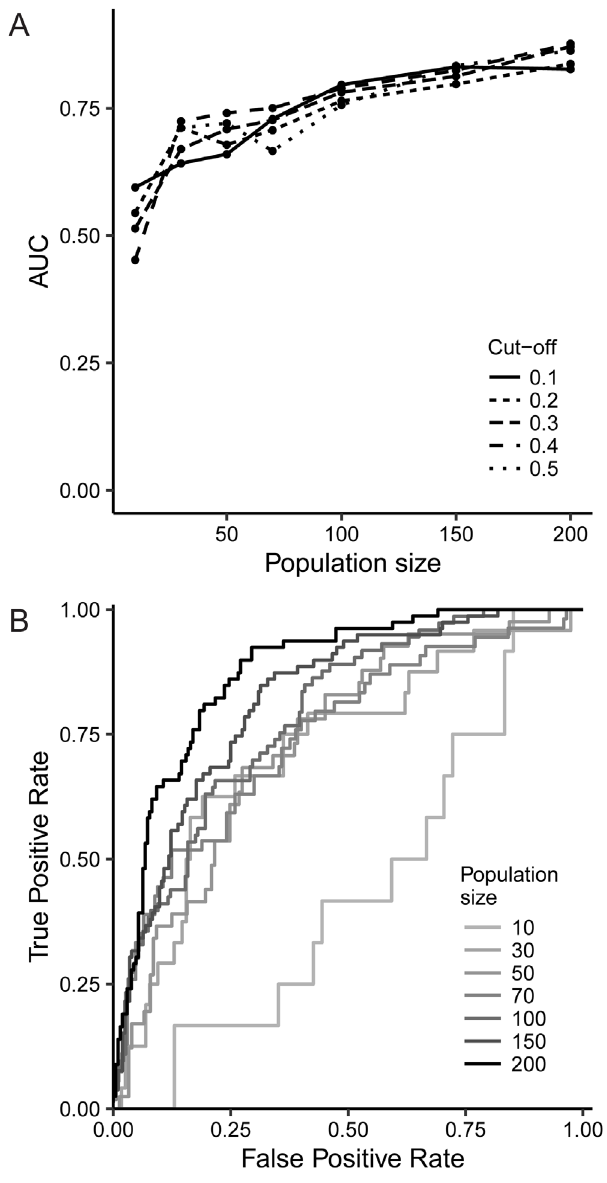
Fig 4. Simulated data based on the Burkholderia dataset. (A) Evolution of the AUC with sample size, for different cut-offs on what is considered to be an immunogenic response. (B) ROC curves for different population sizes, based on a cut-off for immunogenicity of